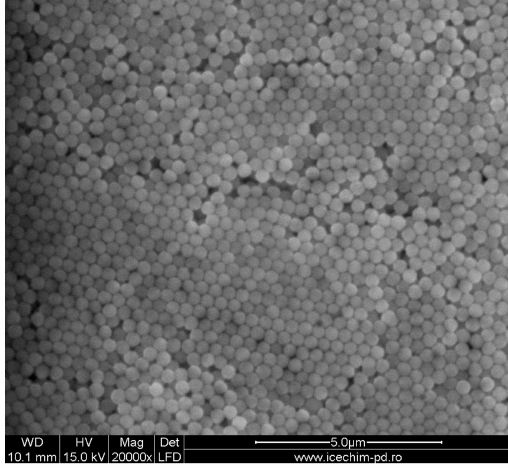
Figure 3. SEM image of the TEOS / O 8 TES based